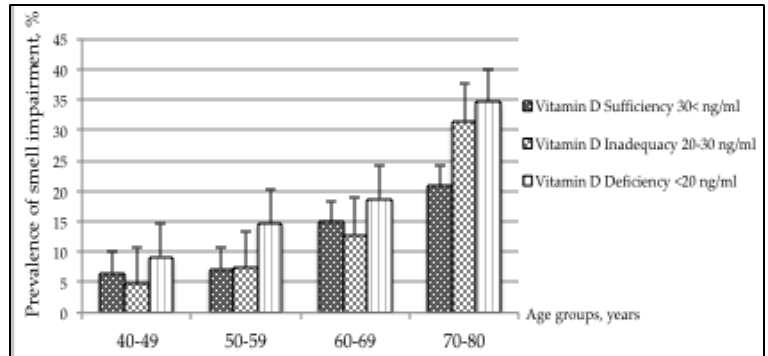
Figure 1. Prevalence of smell impairment across age groups by levels of Vitamin D.